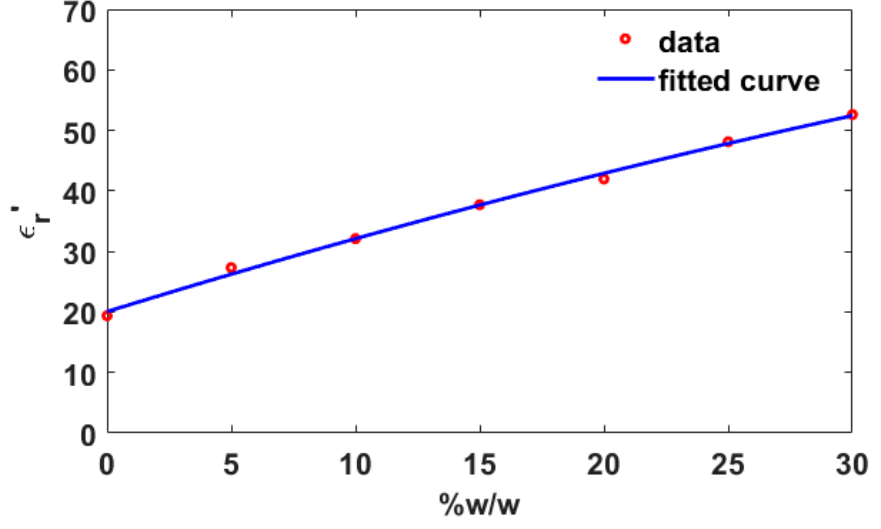
Figure 14. The curve fitting of the real part of complex relative permittivity at the frequency of 0.6 GHz.